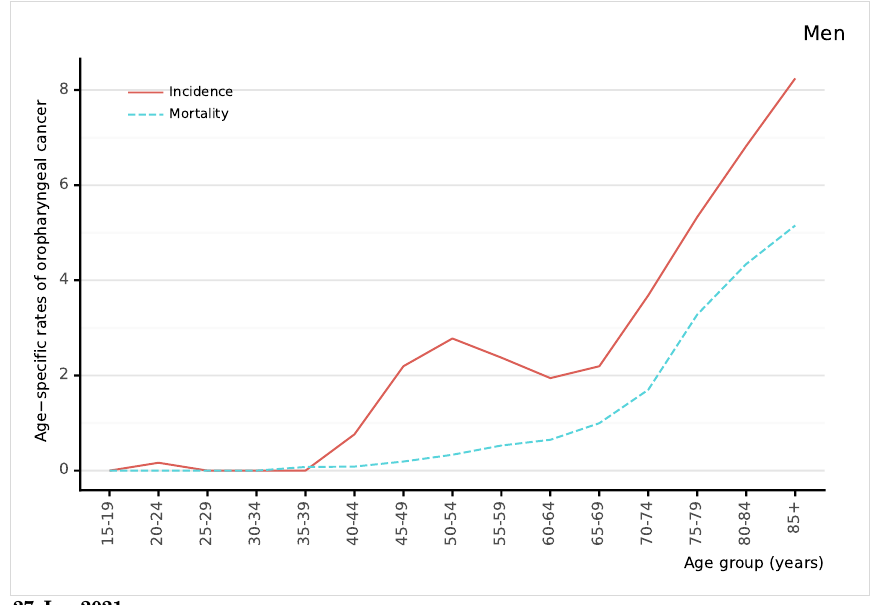
Figure 40: Comparison of age-specific oropharyngeal cancer incidence and mortality rates among men in Peru (estimates for 2020)